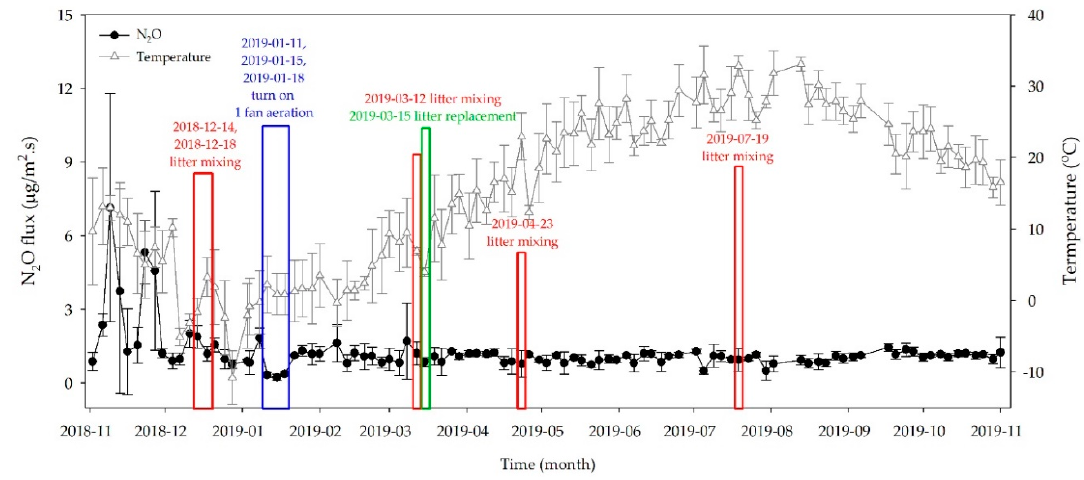
Figure 6. Variation in average N 2 O flux from litter on the day of sampling during the study (error bars represent the standard deviation of the average).